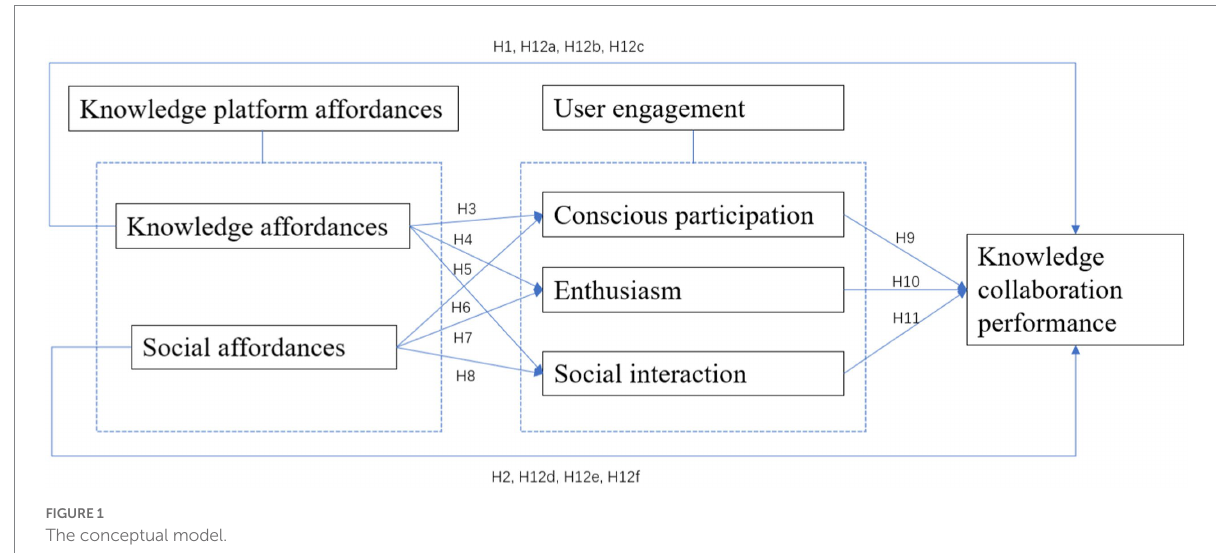
FIGURE 1 The conceptual